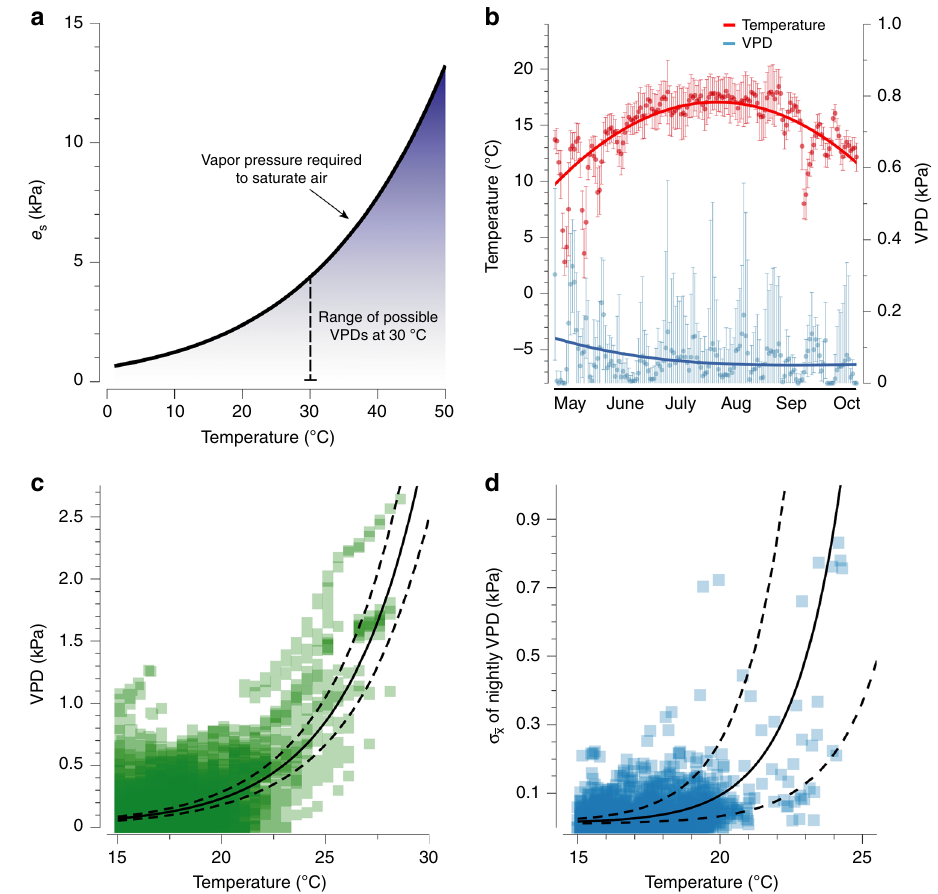
Fig. 1 The risk of desiccation increases exponentially with warming. a Physical relationship between saturation vapor pressure ( e s ) and air temperature indicates that VPDs are likely to become drier and more variable as climates warm. Blue shading indicates more water required to saturate the air, whereas white indicates less water required for saturation. b Seasonal variation in average nightly temperature and VPD (with standard deviations) from dataloggers during peak times of the year for surface activity in salamanders. Temperature (right axis) is displayed in red and VPD (left axis) is displayed in blue. c , d Non-linear regression analyses with 95% con fi dence intervals indicated that VPDs ( c ) and the nightly variation in VPD ( d ) increase exponentially with